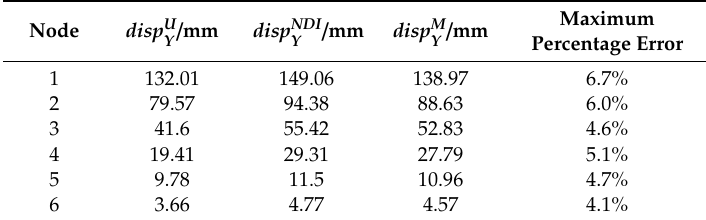
Table 4. The maximum percentage error among the individual nodal displacements, disp U are, respectively, the displacement computed form the unmodified and modified strain measurements with iFEM.